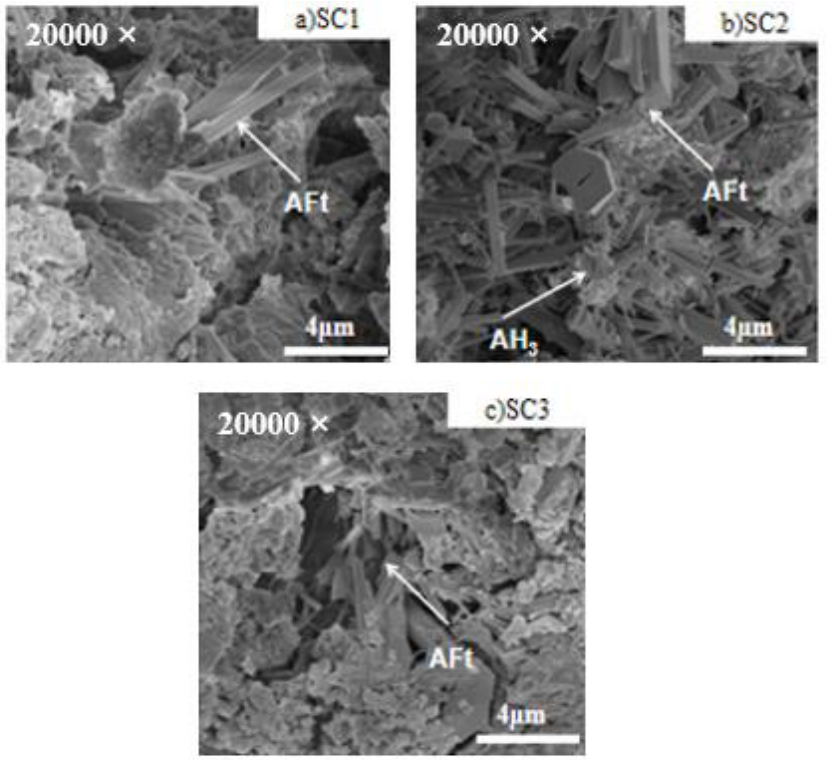
Figure 10. SEM-SE morphology of hydrated sample of SC1-SC3 at 3 days of age.